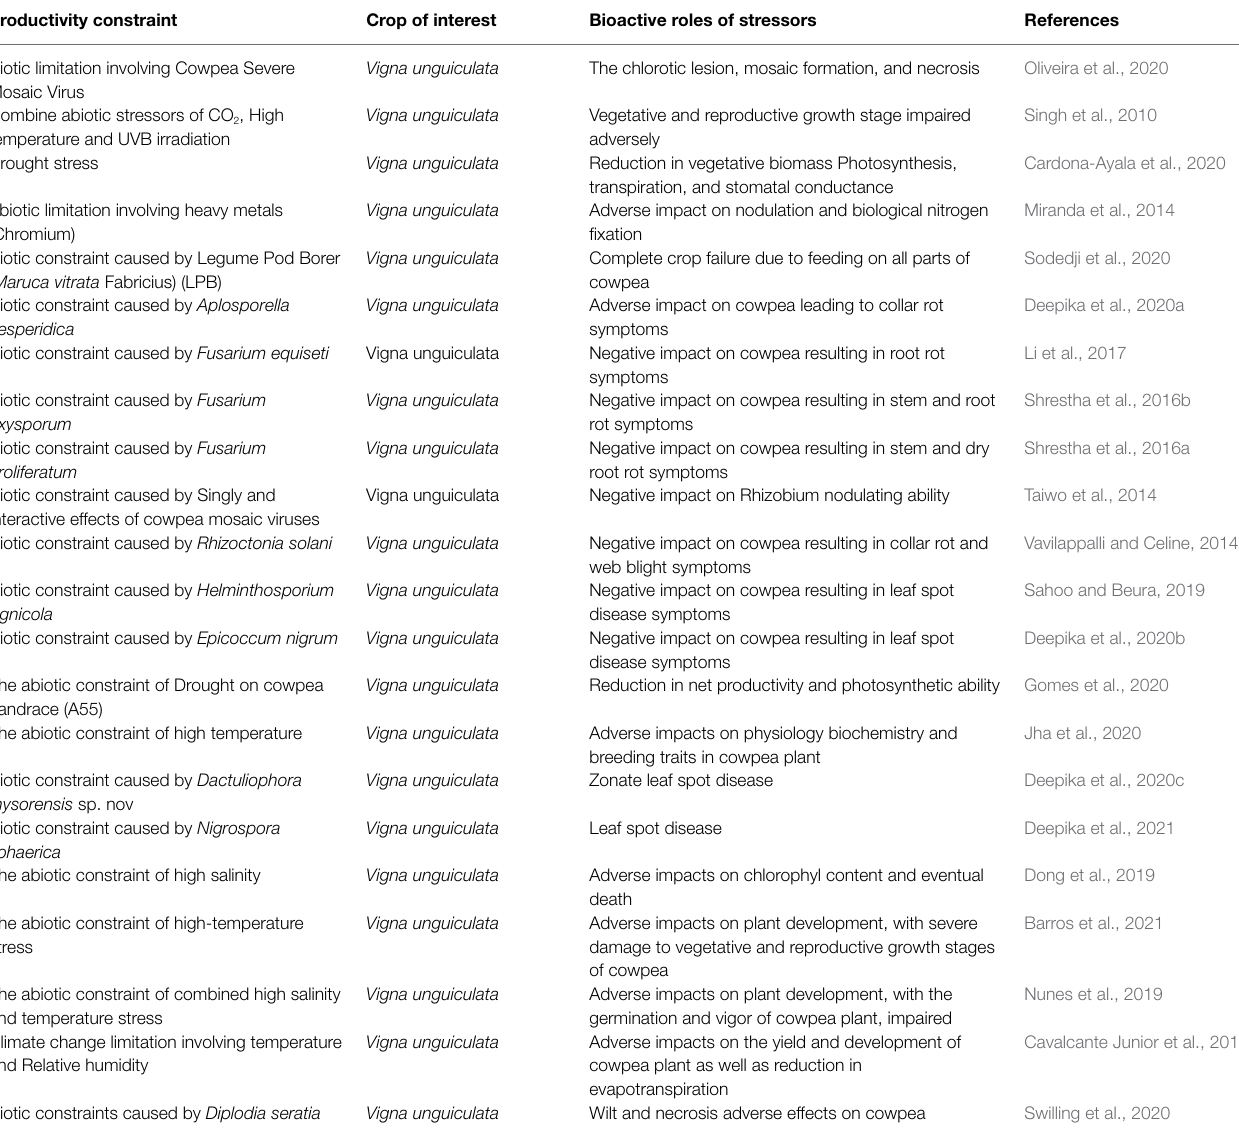
TABLE 2 | Highlight of constraints limiting productivity enhancement of cowpea plant in major producing nations of the